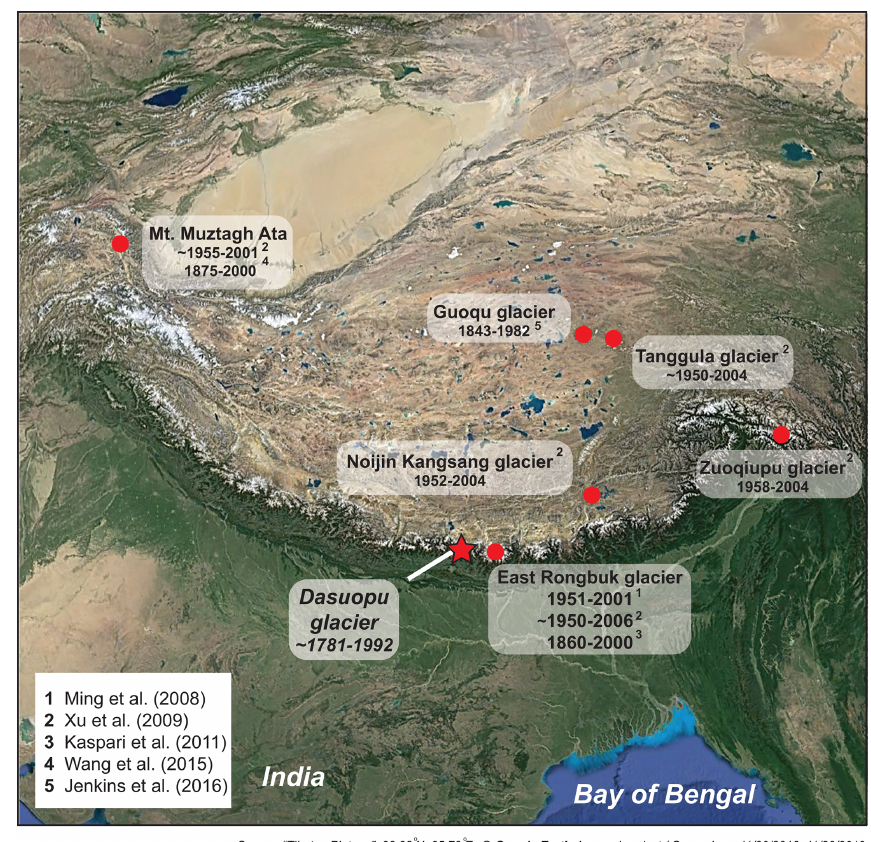
Figure 1. The location of Dasuopu glacier, Mt. Xixiabangma, and other ice cores that have provided a historical record of BC deposition in the region. The span of each BC record is